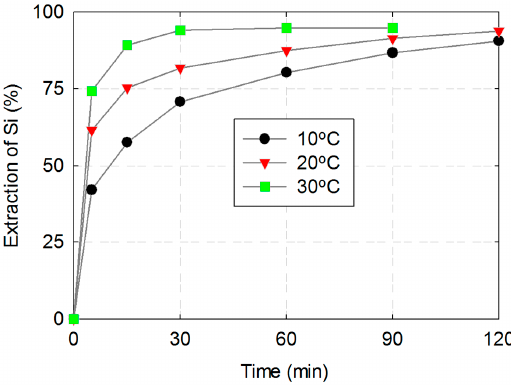
Figure 6. Si dissolution from blast furnace slag using aqueous solution of 5% acetic acid.